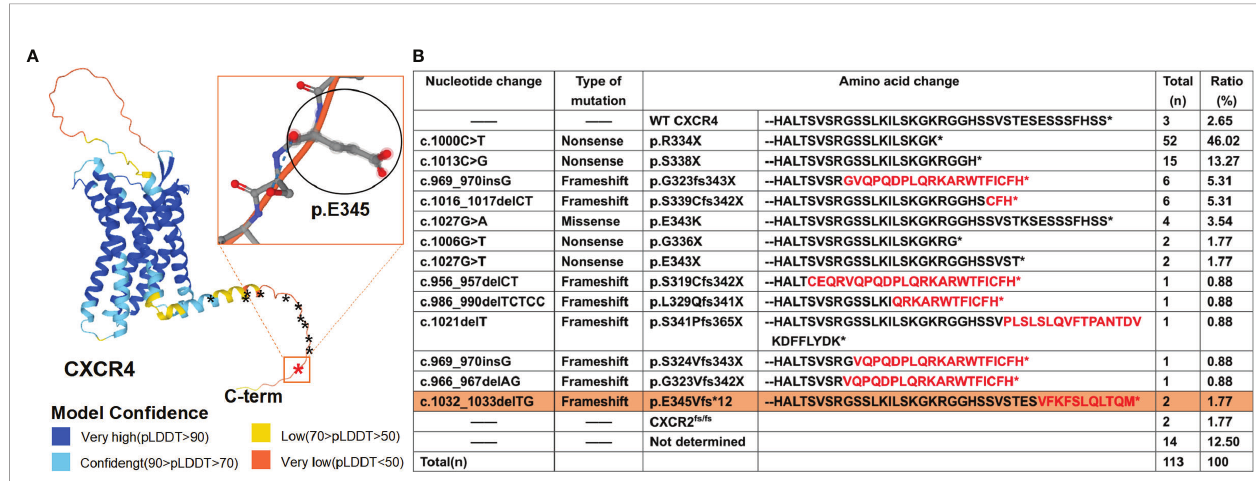
FIGURE 1 | WHIM syndrome caused by mutations in C-terminal of CXCR4 and other causes. (A) Three-dimensional (3D) structure of CXCR4, predicted by using AlphaFold developed by DeepMind and EMBL-EBI, is shown on the left with stars (*) demarcating locations of WHIM mutations. The novel mutation identi fi ed in this study is marked in red, with the rectangular box showing its 3D structure, and the previously reported mutations in the CXCR4 gene are marked in black. AlphaFold produces a per-residue con fi dence score (pLDDT) between 0 and 100. Some regions below 50 pLDDT is unstructured in isolation, which is a reasonably strong predictor of disorders. (B) Summary of 111 reported cases in the WHIM syndrome spectrum literature and two novel cases (in this study). Neo-sequence imposed by frame-shift mutations is in red. The novel mutation is highlighted with orange